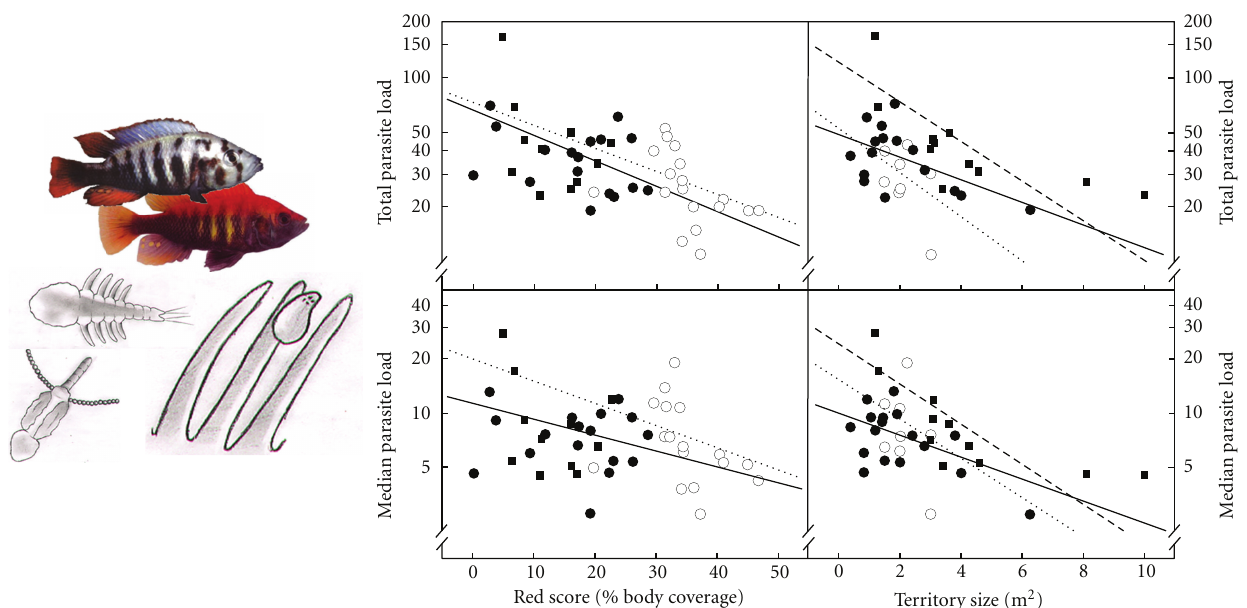
Figure 5: Left: the cichlid fish sister species Pundamilia pundamilia and P. nyererei from Lake Victoria di ff er in their parasite assemblages, dominated by larval nematodes in the internal organs and ectoparasitic copepods on the gills, respectively (photo of P. pundamilia Ole Seehausen, photo of P. nyererei courtesy of Martine Maan, drawings courtesy of Jeanette Bieman). Right: males with bright red (shown) or bright blue (not shown) colouration and males with larger territories were found to carry lower parasite infections than males with duller coloration [66, 101] and females use male nuptial colouration in intra- and interspecific mate choice [102, 103]. Figure reproduced with permission from Maan et al.